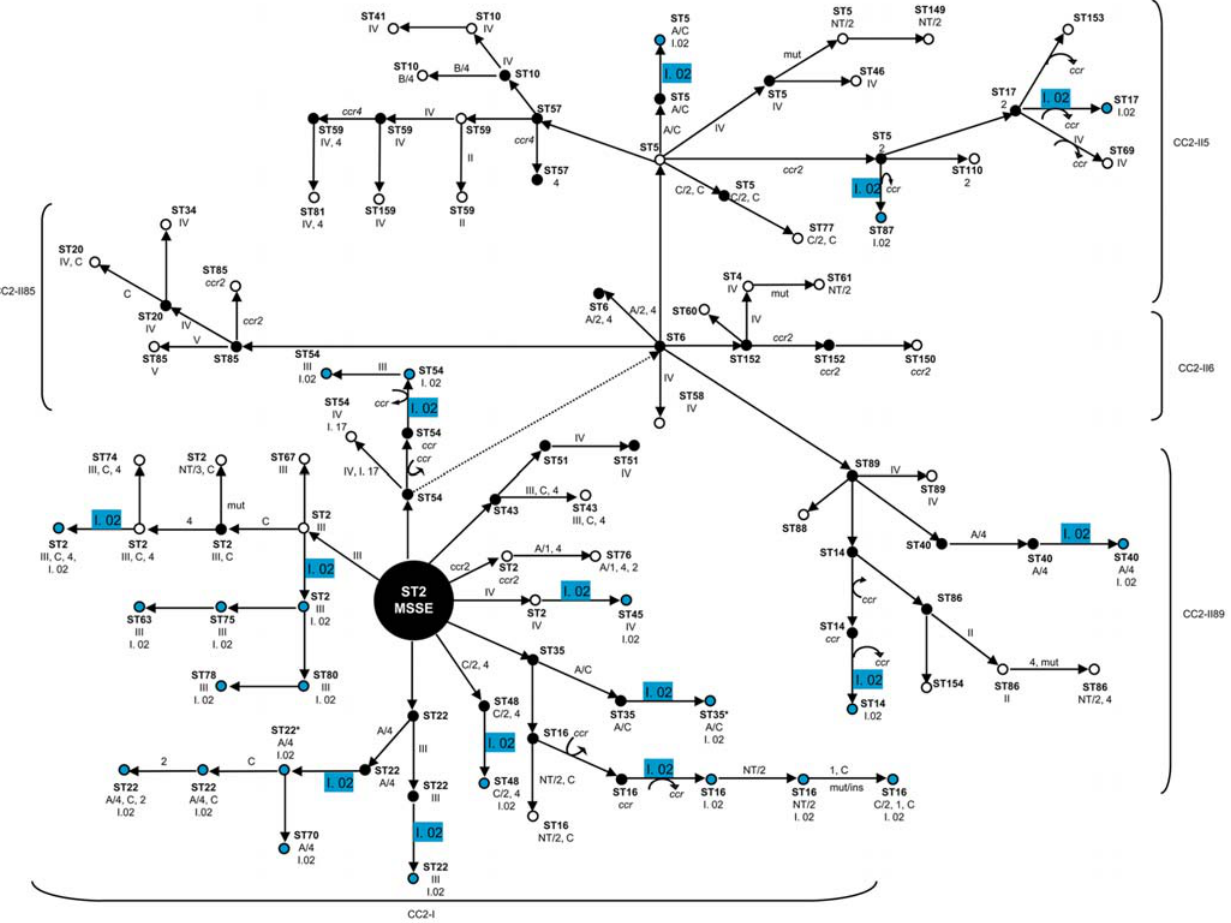
Figure 4. Proposed evolutionary model for ACME acquisition within CC2 clusters and sub-clusters (CC2-I, CC2-II6, CC2-II5, CC2-II85, CC2-II89). Each dot represents a strain with specific characteristics with respect to ST and content of the different mobile genetic elements, namely, SCC mec (represented by types I-VI), SCC non- mec (represented by the allotype of ccr ) and ACME types (represented by Roman numbers followed by Arabic numbers). The occurrence of genetic events involving a single MLST locus variation and/or SCC and ACME acquisition/deletion are indicated by arrows and the elements involved in the event are shown next to the arrow. Blue and white dots represent strains found within the collection studied, and black dots represent hypothetical S. epidermidis strains. ACME I.02 acquisition is represented in blue.